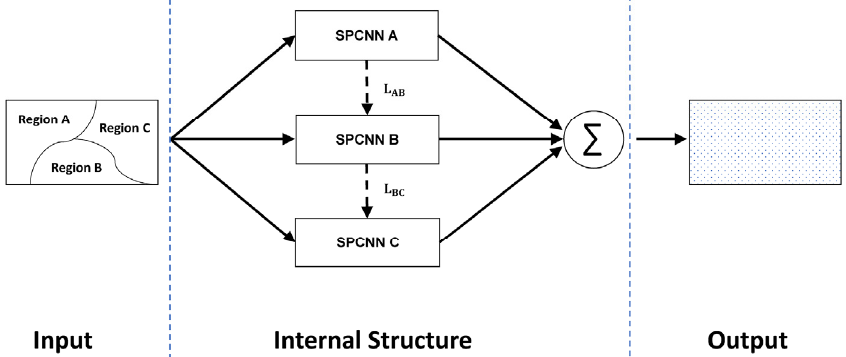
Figure 3. Structure of group-isolated HPCNN.